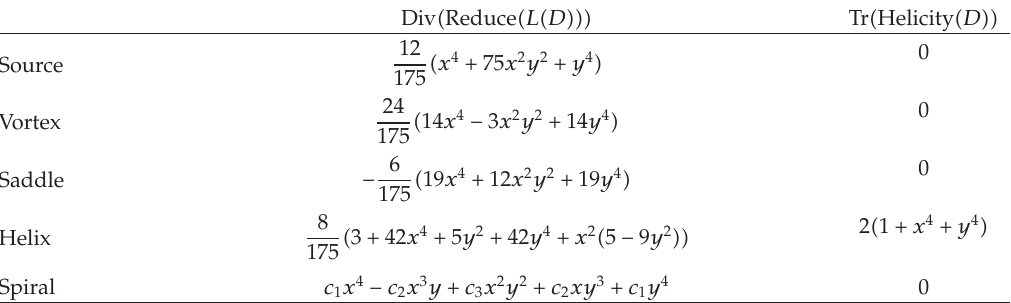
Table 5: Detecting saddles and helices in third-order tensor